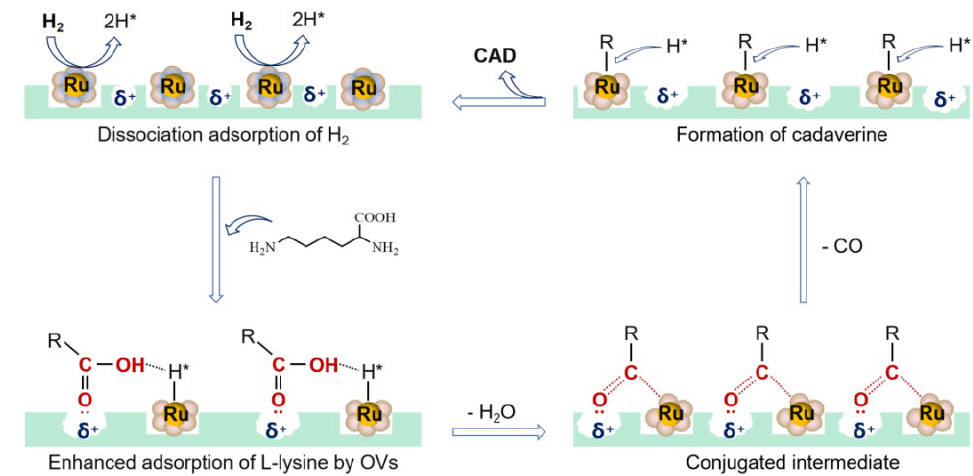
Figure 8. Proposed mechanism of decarboxylation of L-lysine to cadaverine.